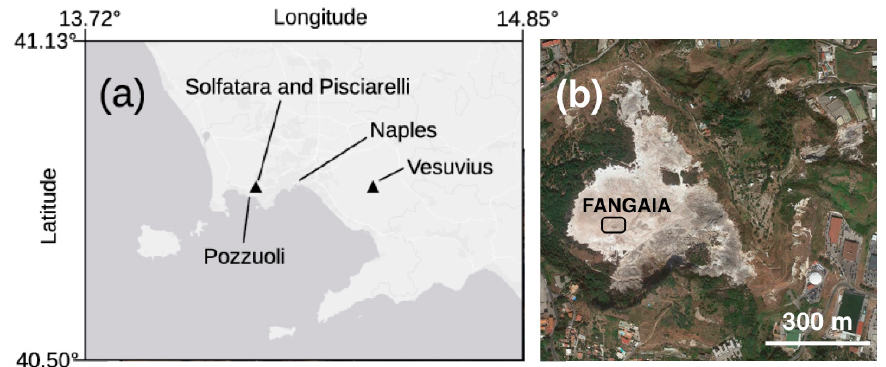
Figure 1. Location map of the ( a ) Solfatara and Pisciarelli magmatic-hydrothermal systems, inside the Campi Flegrei caldera, Gulf of Pozzuoli, Naples, and ( b ) Fangaia mud pool inside the Solfatara crater.